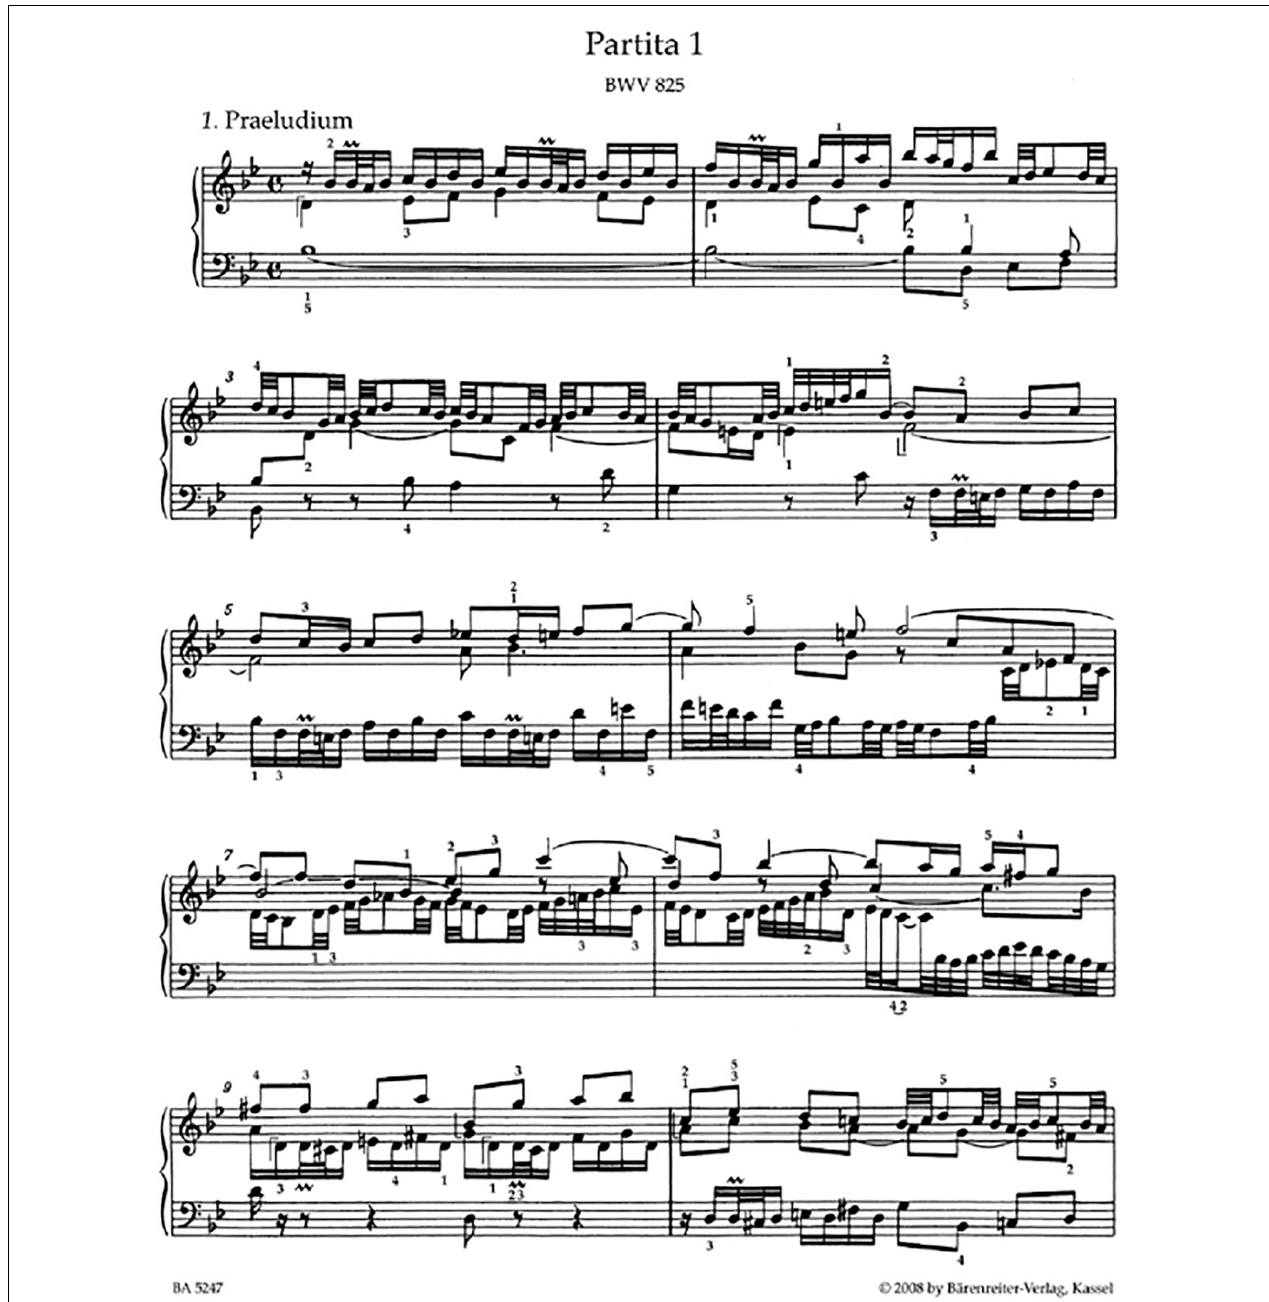
FIGURE 1 | Page 1 from the score of J. S. Bach’s Partita #1 for piano, BWV